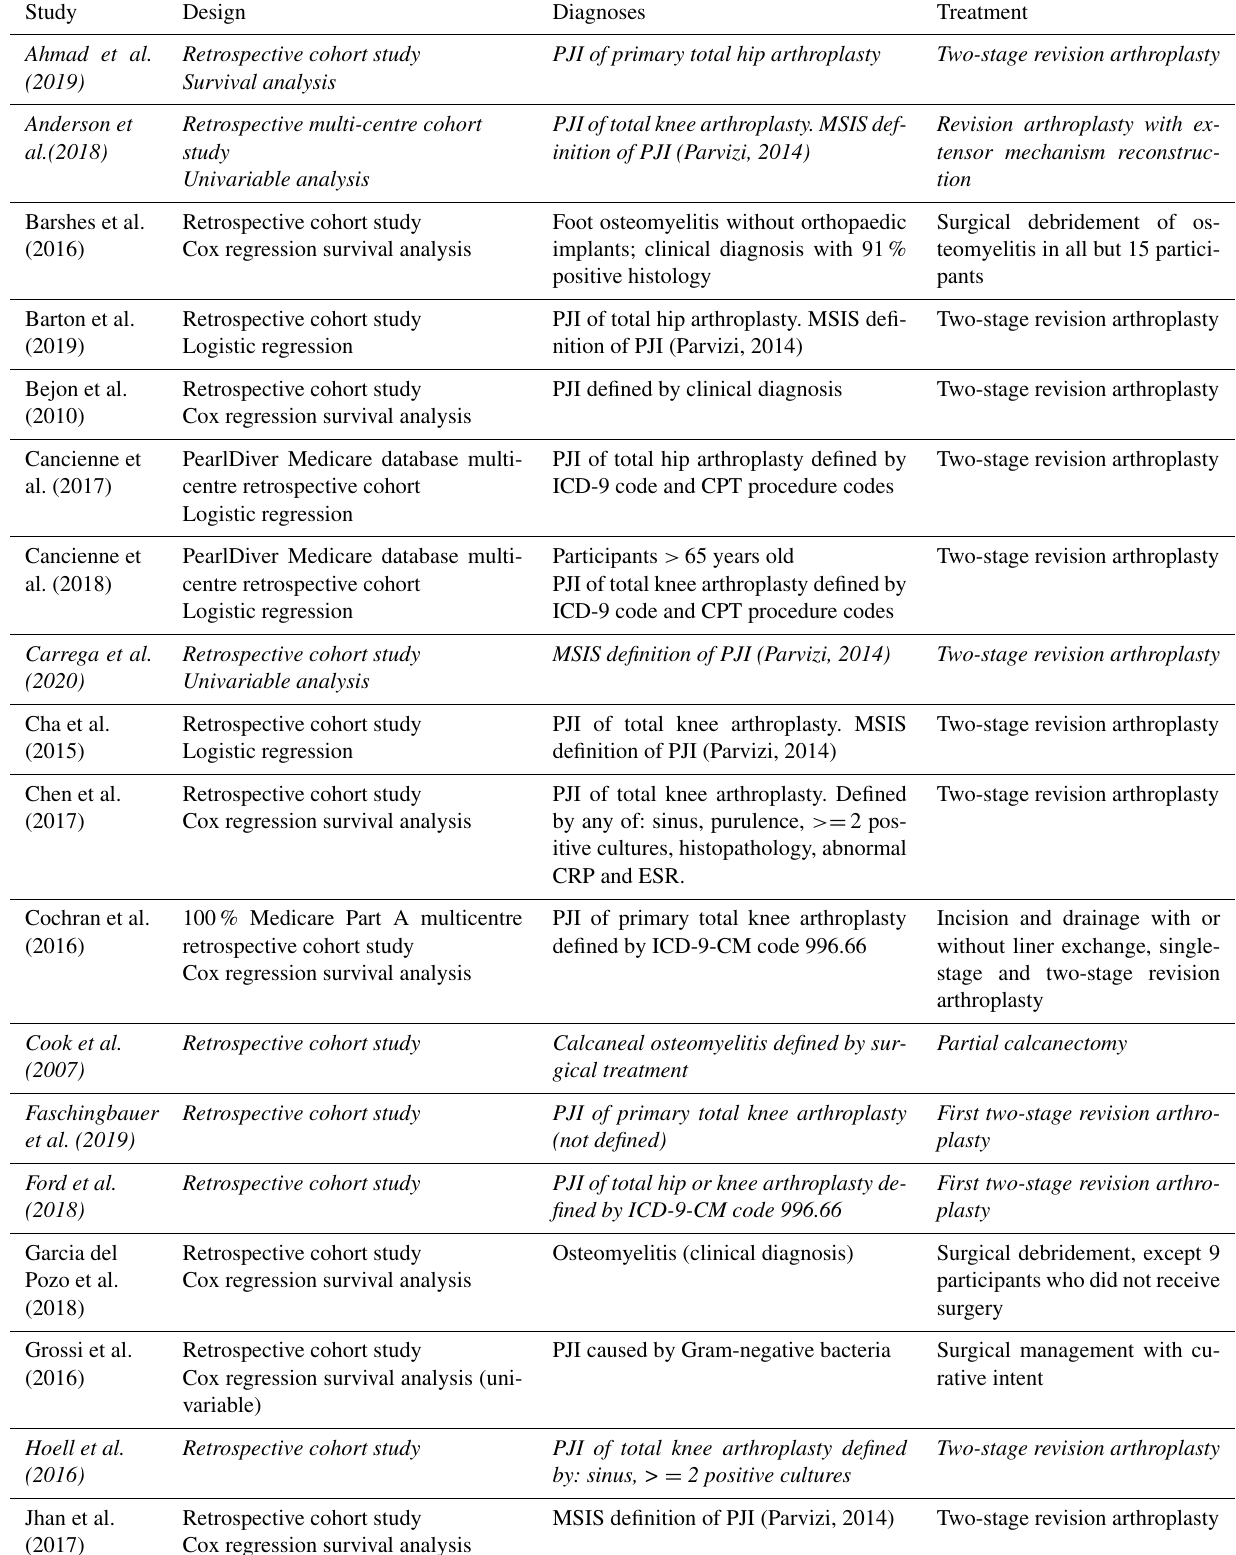
Table 1. Characteristics of participants and design of included studies. Italicised studies did not describe multivariable prognostic modelling and were considered epidemiologic studies for the purposes of